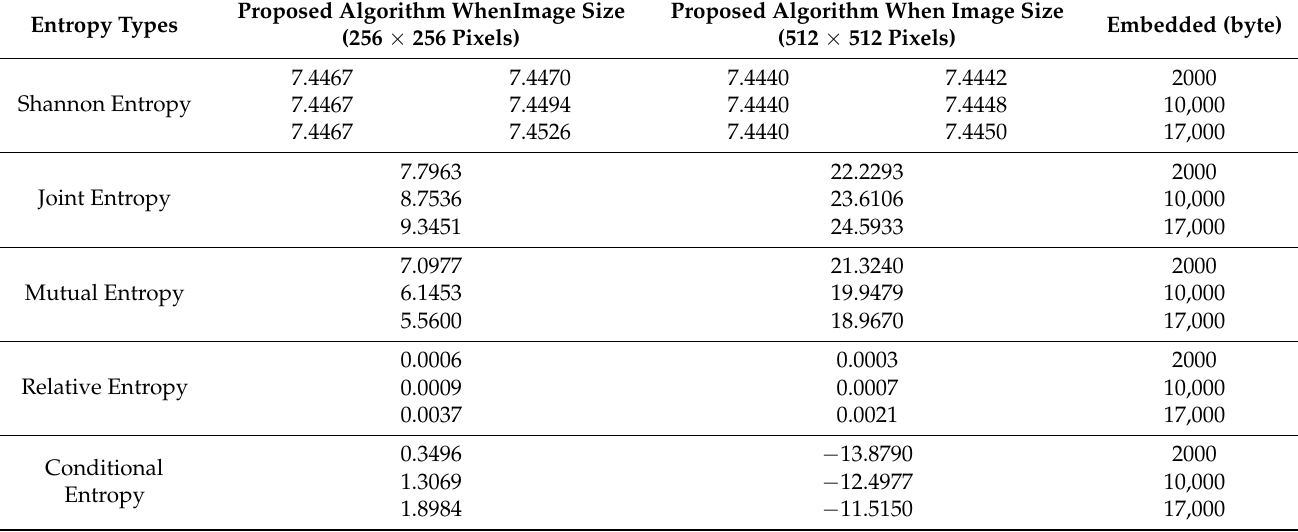
Table 4. All entropy types resulting from comparison between cover and stego